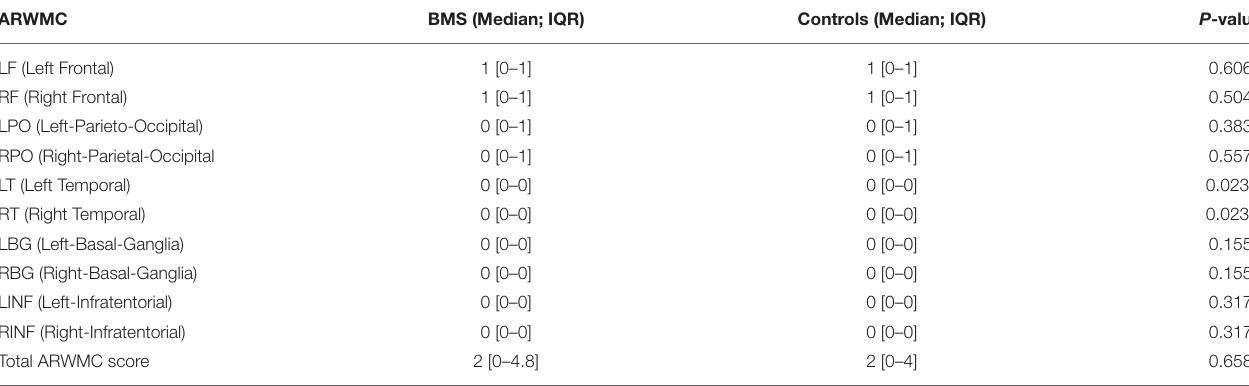
TABLE 5 | Analysis of the ARWMC scores of patients with BMS and control